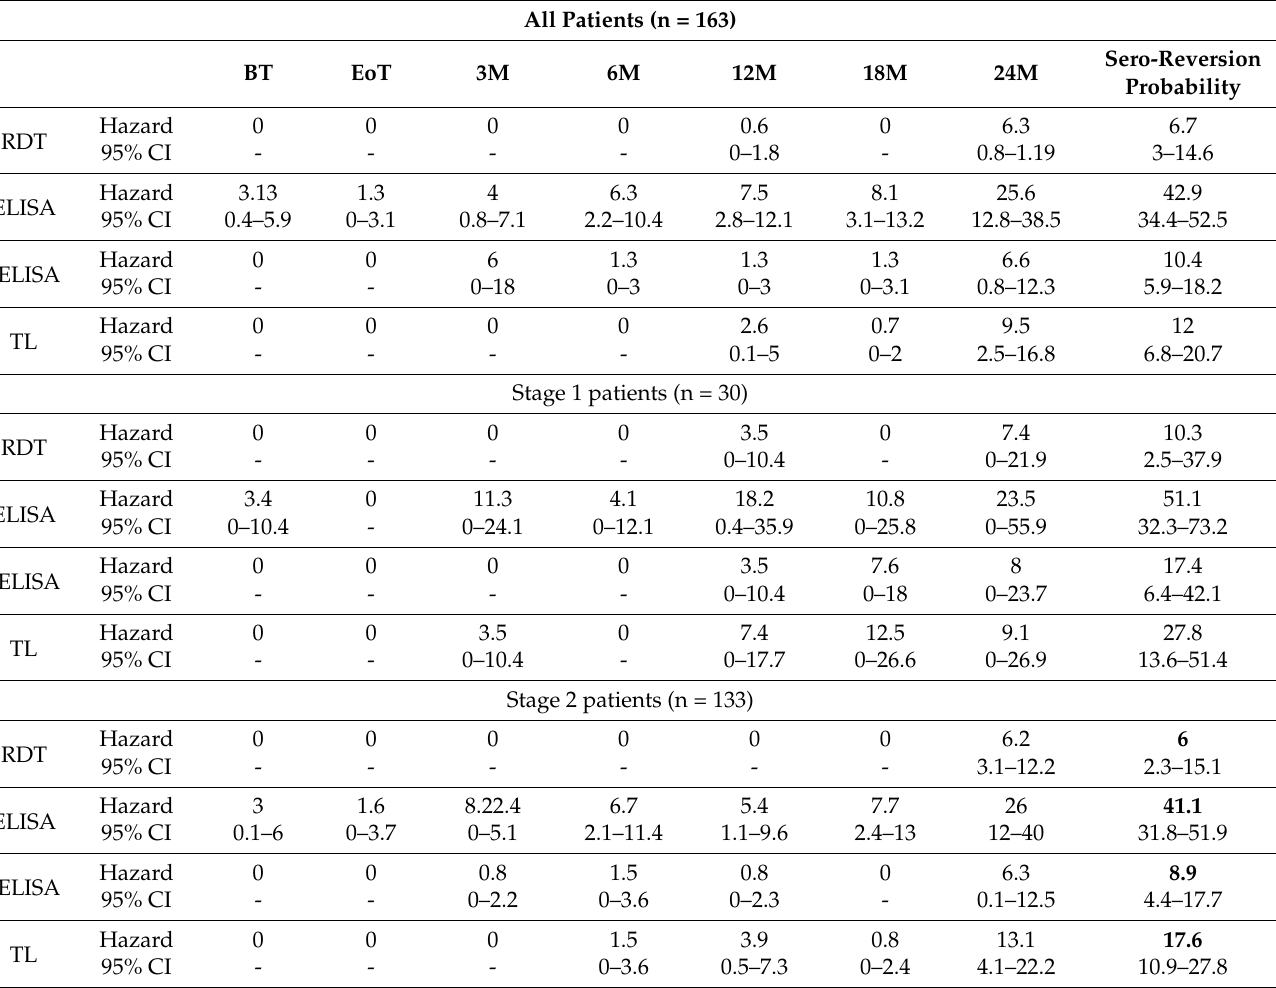
Table 3. Sero-reversion hazards (as percentages) for each timepoint and serological test, with 95% confidence